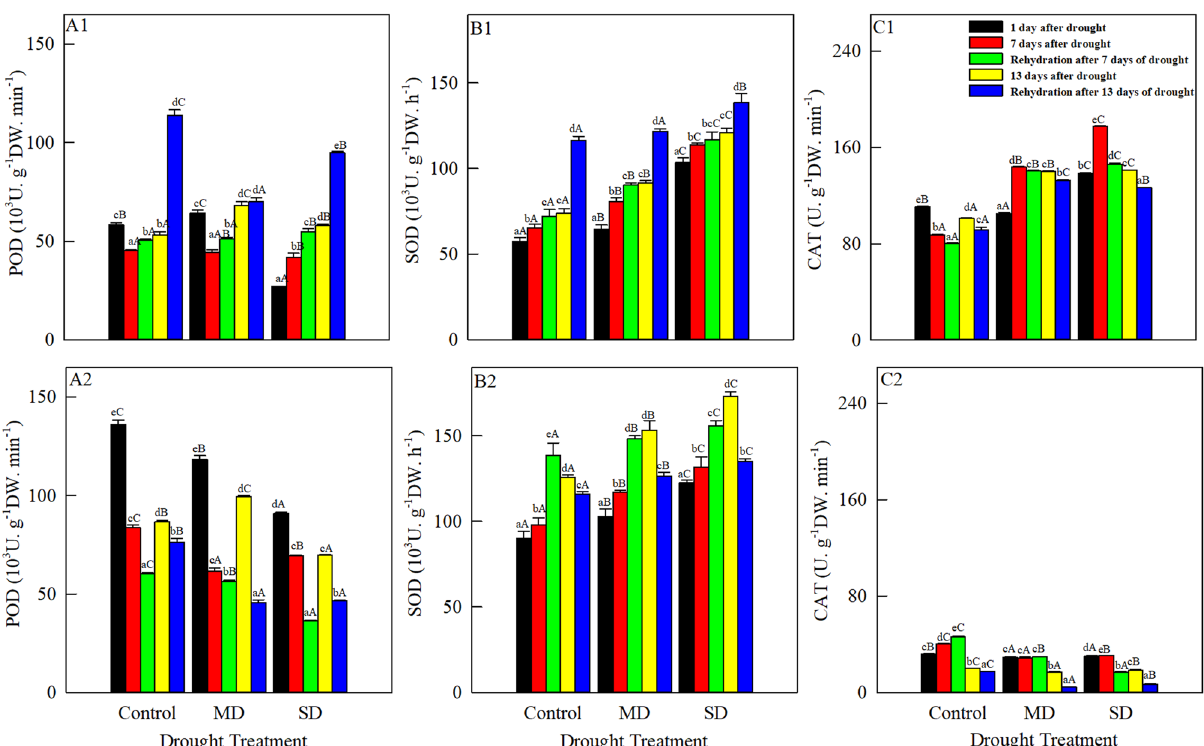
Figure 3. Changes in POD, SOD and CAT of A. squarrosum ( A1 , B1 , C1 ) and S. viridis ( A2 , B2 , C2 ) under drought stress (August 1, 7, 13) and rehydration (August 8, 14). Different lowercase letters indicate significant differences among days for the same treatment. Different capital letters indicate significant differences among drought treatments for the same day.